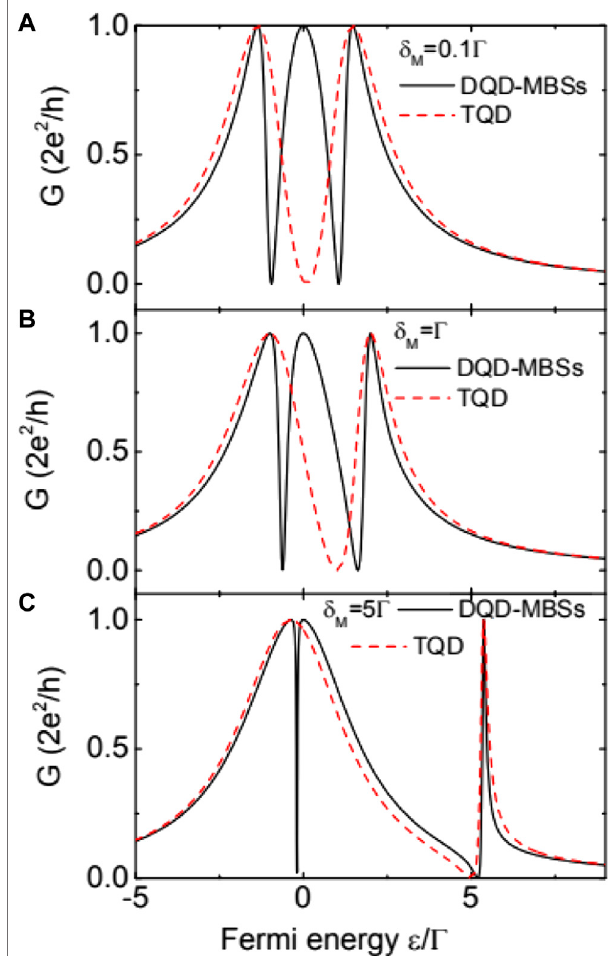
FIGURE 4 | Linear conductance as a function of the Fermi energy for DQD-MBSs and TQD con fi gurations and different values of direct overlap amplitude δ M and fi xed λ (cid:1) 1 and q (cid:1) 1. In (A) we set δ M (cid:1) 0 . 1 Γ , and δ M (cid:1) Γ in (B) , δ M (cid:1) 5 Γ in (C) . The conductance in (C) displays typical asymmetric Fano line-shape in higher energy